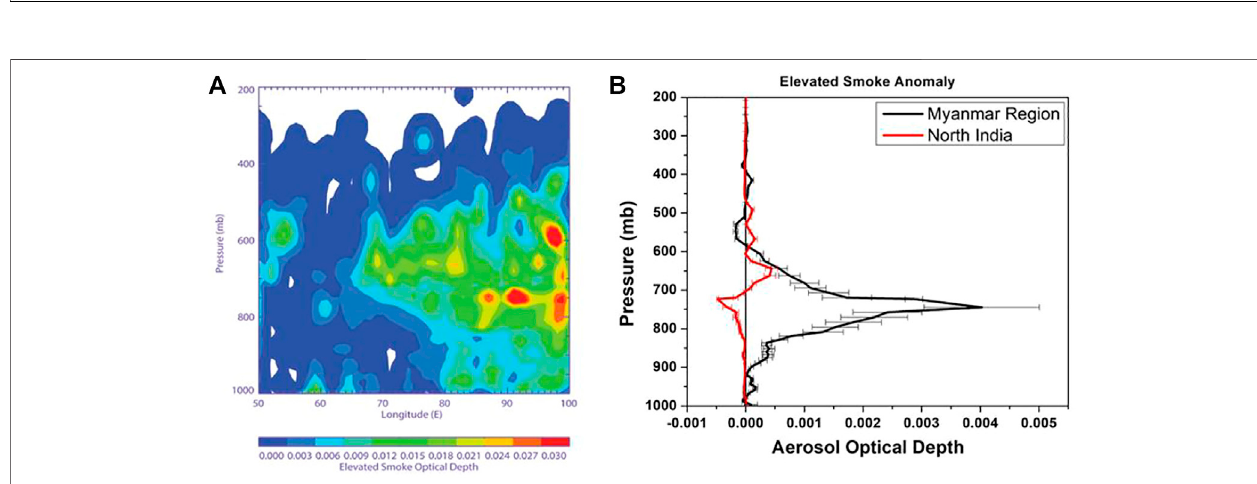
FIGURE 2 | (A) Spatial distribution of changes in fi re counts during the lockdown period from (A) MODIS (2020-climatology). (B) Elevated smoke aerosol optical depth from CALIPSO at 532 nm (2020-climatology) Boxes in (A,B) indicate North India and Myanmar regions.